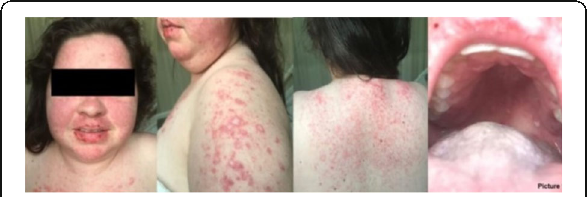
Fig. 1 (abstract P512). Scaly erythematous lesions on her face, chest and torso, as well as crusty lip lesions and oral ulcerations presenting with granulation tissue and erythematous halo in